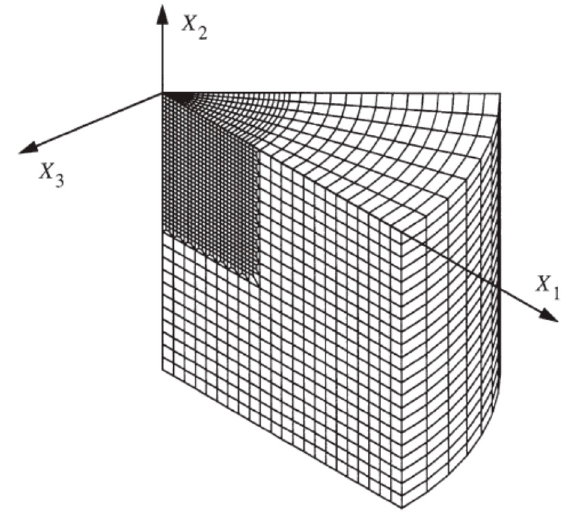
Figure 3. Finite element mesh used for the numerical calculations. In all cases a prescribed indentation depth was applied in the negative X 2 -direction. The figure shows mesh details close to the region of contact.